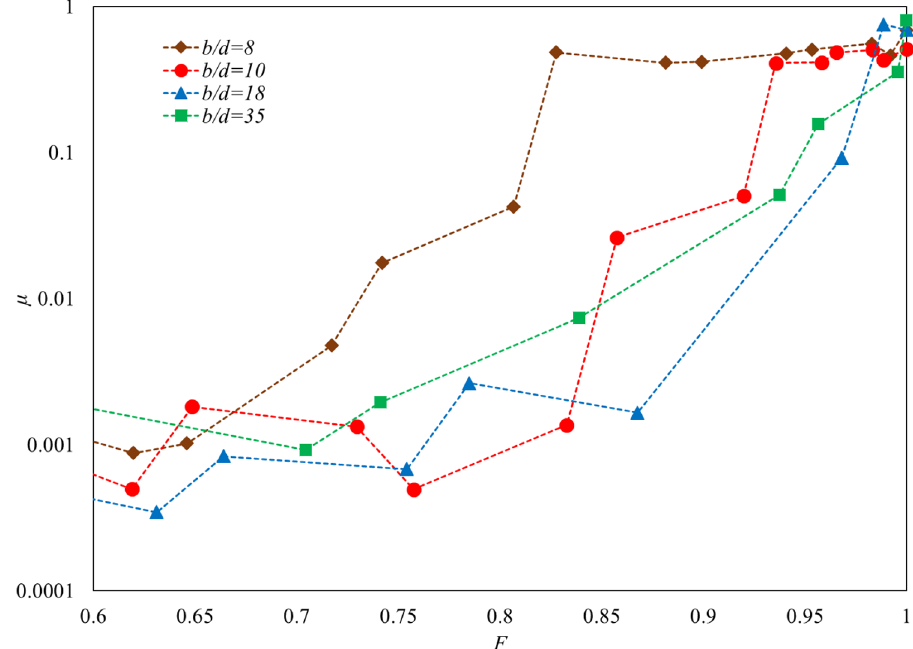
Fig. 6. Penetration ratio m as a function of the solid fraction F for different b/d ratios at a constant.